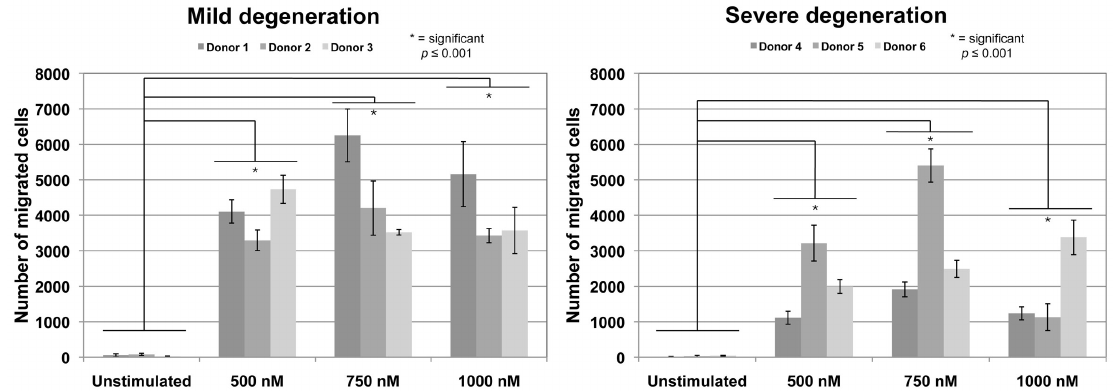
Figure 1. Chemotaxis assay. Migration of lumbar AF cells derived from donors with mild disc degeneration (donors 1–3) and severe disc degeneration (donors 4–6) (all measured in triplicates; error bars: standard deviation). Significant increased migration (* p ≤ 0.001) was found in all CCL25 concentrations (500, 750, and 1000 nM) compared to unstimulated controls. There were no significant differences between concentrations. Also, no significant differences between cells form mild and severe degenerated AF for same CCL25 concentrations were detected.